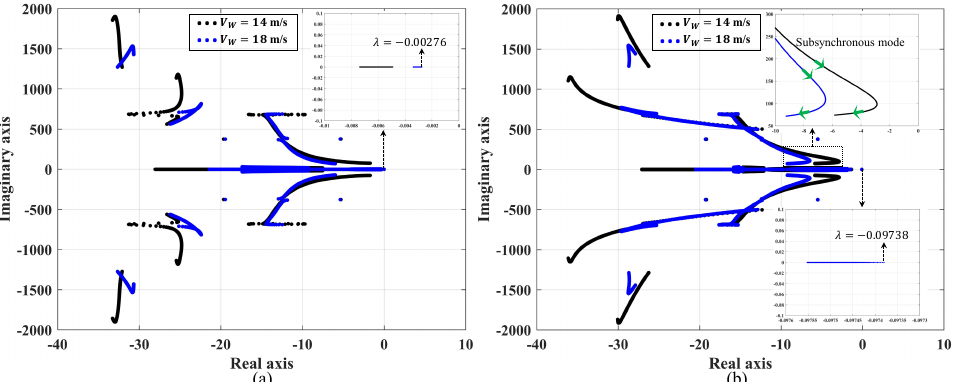
Figure 11. Eigenvalues of the system for low and high wind speeds with proposed ( a ) SSDC-A ( b )